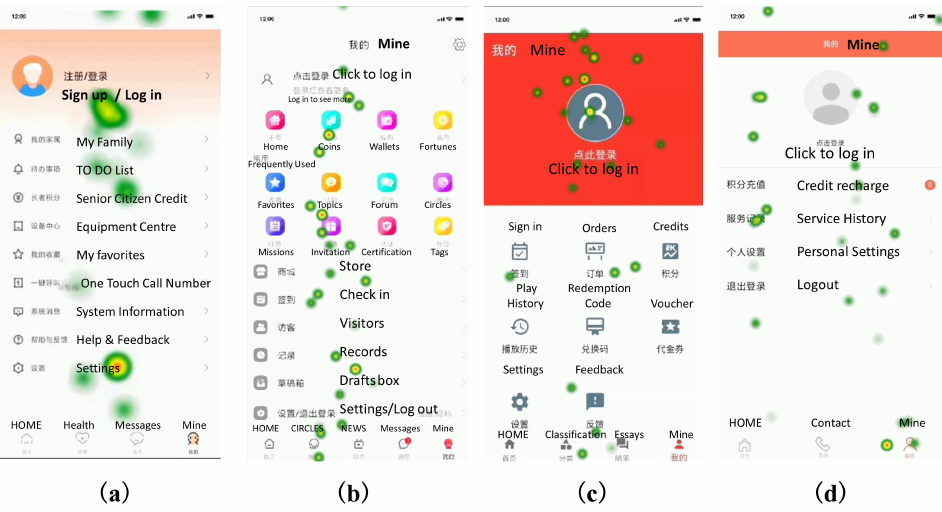
Figure 7. Four product eye movement heat maps: ( a ) C-Life Senior Care APP interface hot spot map; ( b ) Senior Living APP interface hot spot map; ( c ) Senior Care Manager APP interface hot spot map; ( d ) Smart Aging APP interface hot spot